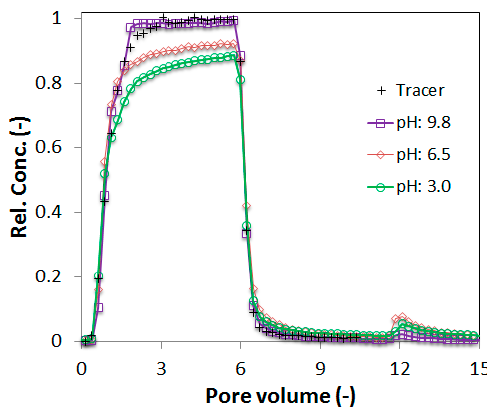
Figure 8. Representative FBP breakthrough curves from column experiments using fire-extinguishing water collected at site 2 adjusted to three different pH.